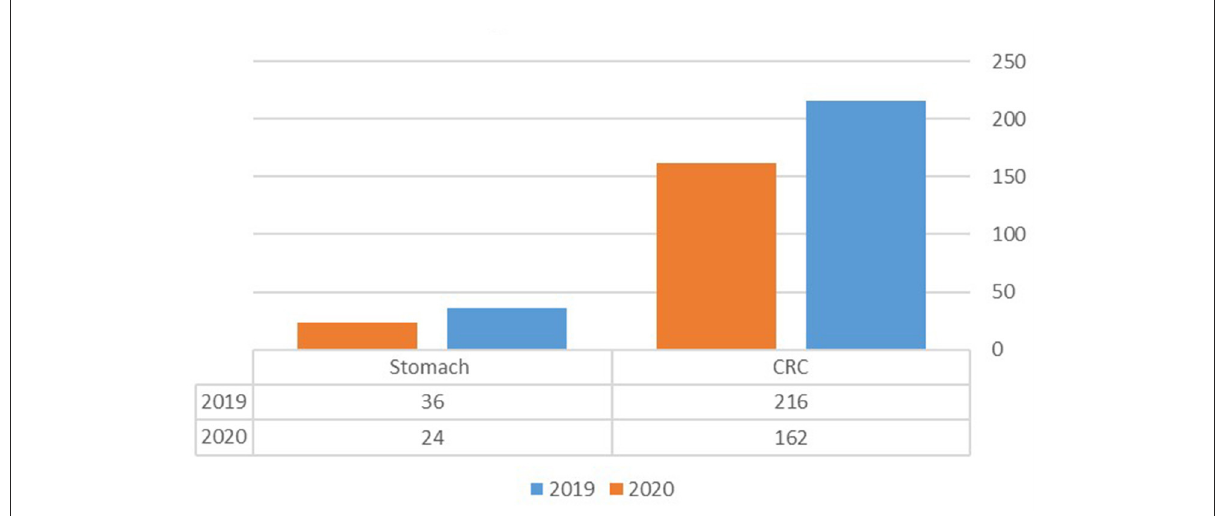
FIGURE1 Number of patients diagnosed with CRC or gastric cancers during the years 2019 and 2020.